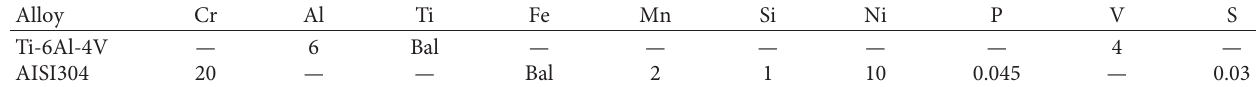
Table 1: Chemical composition of base metals (wt %).